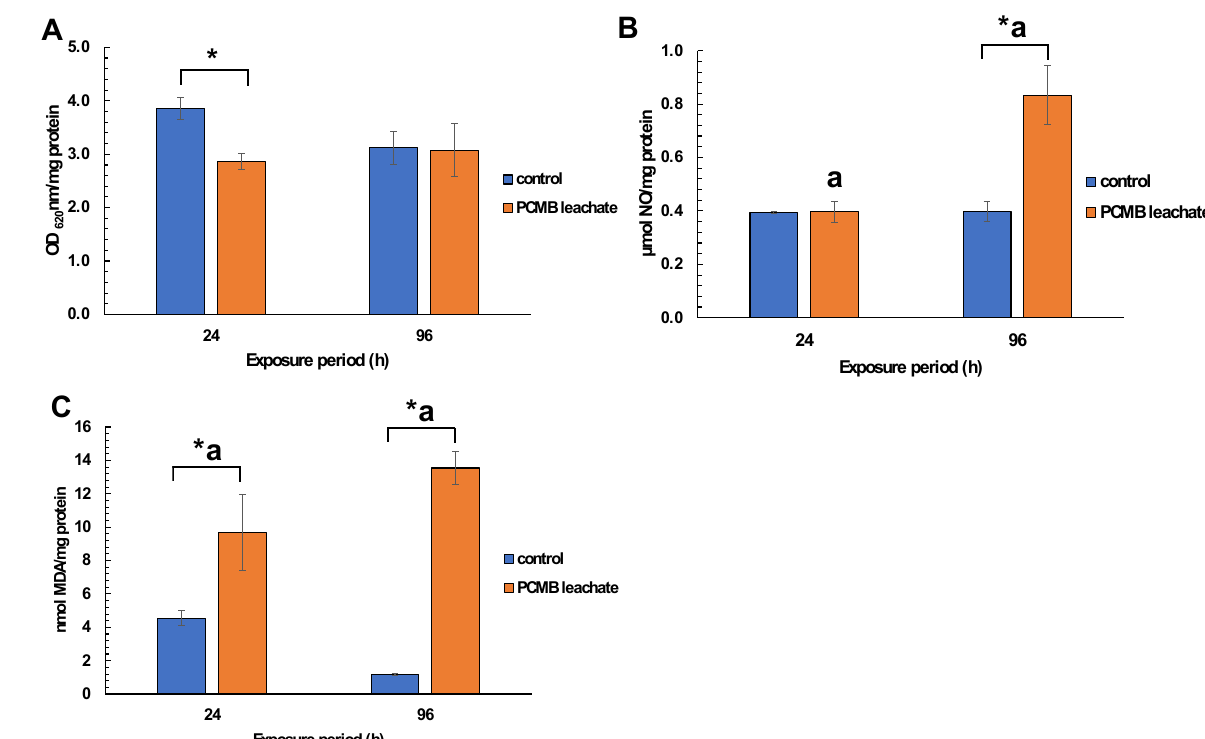
Figure 3. Lysosomal membrane stability (in terms of NRRT values) in hemocytes of mussels ex- posed to PCMB-ASW for 96 h. The results (expressed as min) are mean± SDs for 10 individuals in each case. Asterisks (*) indicate significant difference from the respective control (Mann–Whitney u-test, p < 0.05).